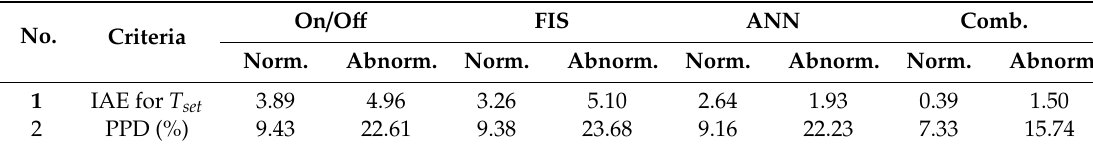
Table 2. Comparison of control accuracy.